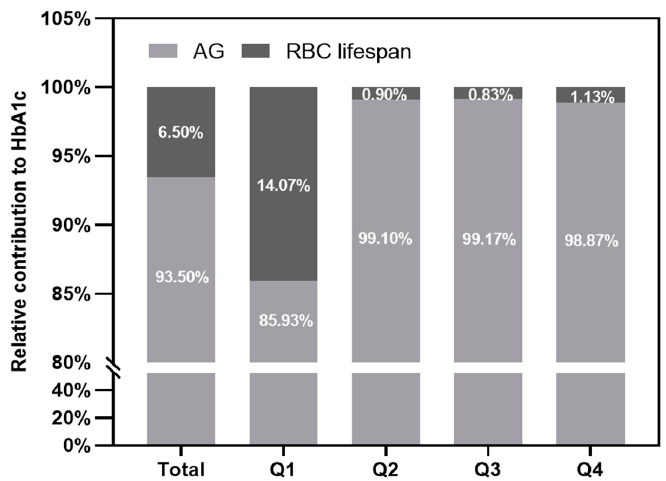
Figure 4. The contributions of average glucose (AG) and red blood cell (RBC) lifespan to glycosyl- ated hemoglobin (HbA1c) test value, respectively. hemoglobin (HbA1c) test value, respectively.